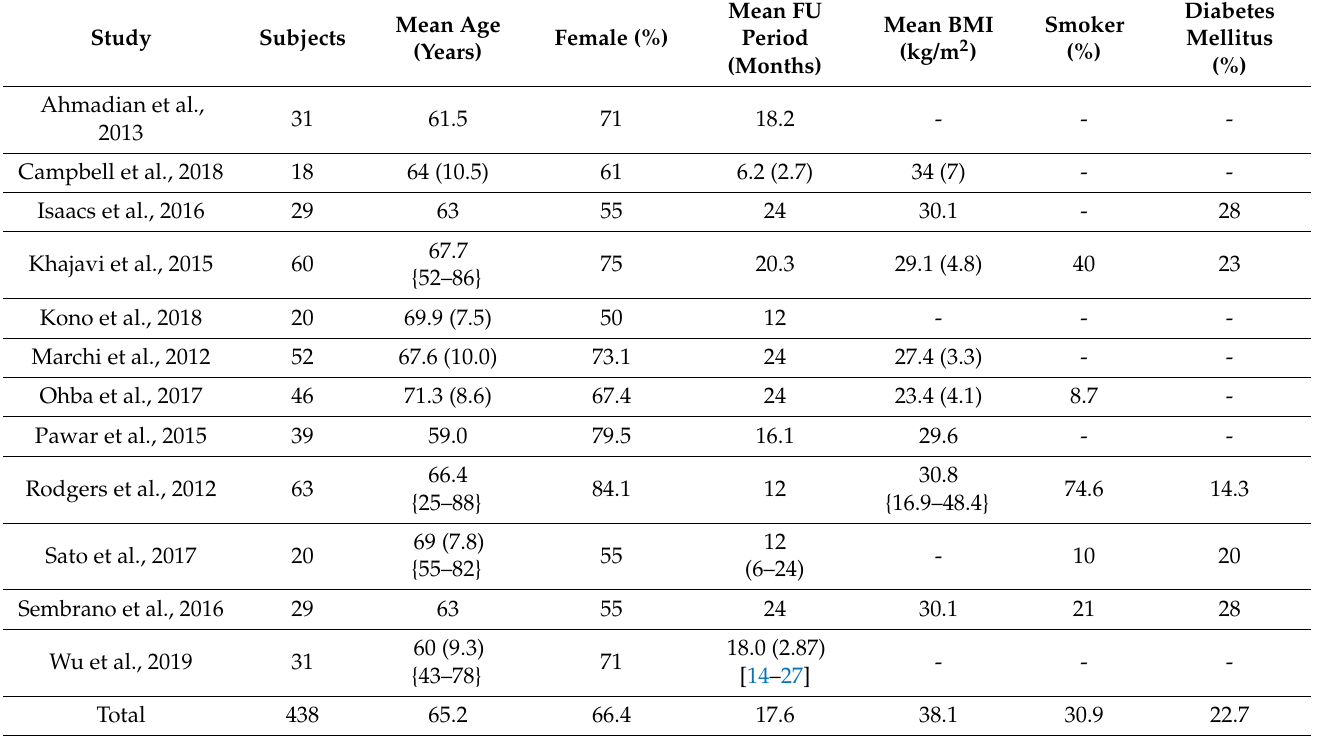
Figure 1. Workflow for identifying included references. Table 1. Demographic data extracted from the included studies.